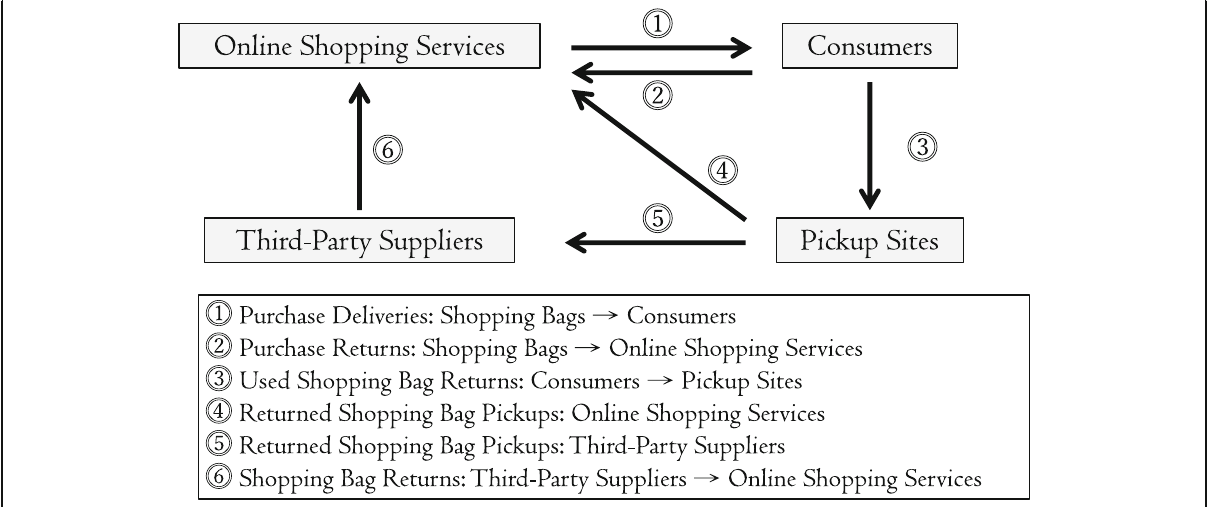
Fig. 4 Recycling of shopping bags in online shopping services in Taiwan